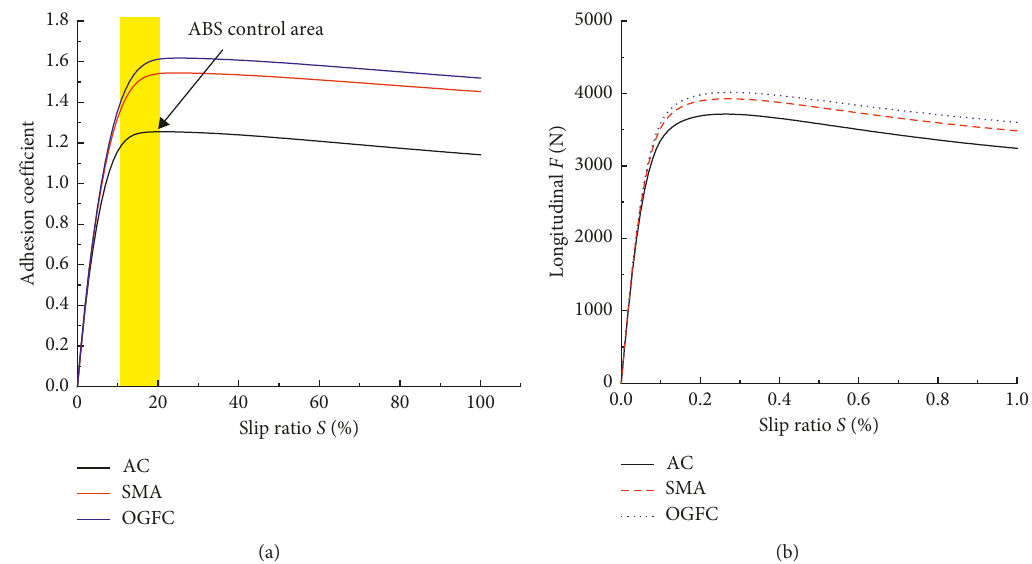
Figure 8: Adhesion characteristic curves of tire and pavement: (a) tire adhesion coefficient variation and (b) tire longitudinal force